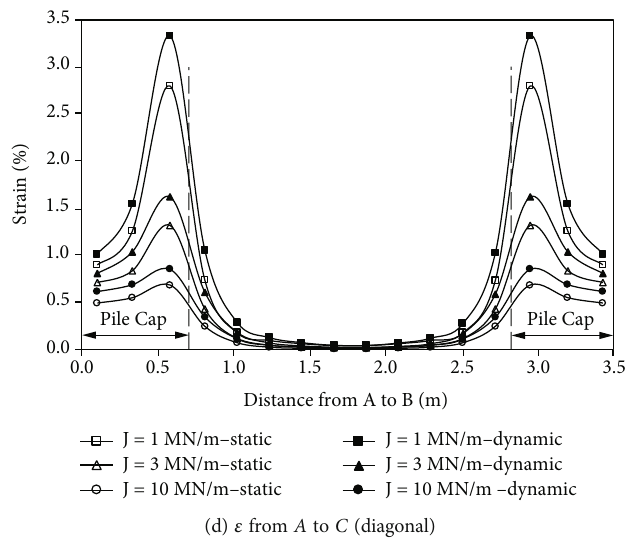
Figure 4: Settlement ( δ ) and strain ( ε ) of geogrid varied with the sti ff ness ( s = 2 : 5 m, h = 3 : 5 m, υ = 60 km/h).